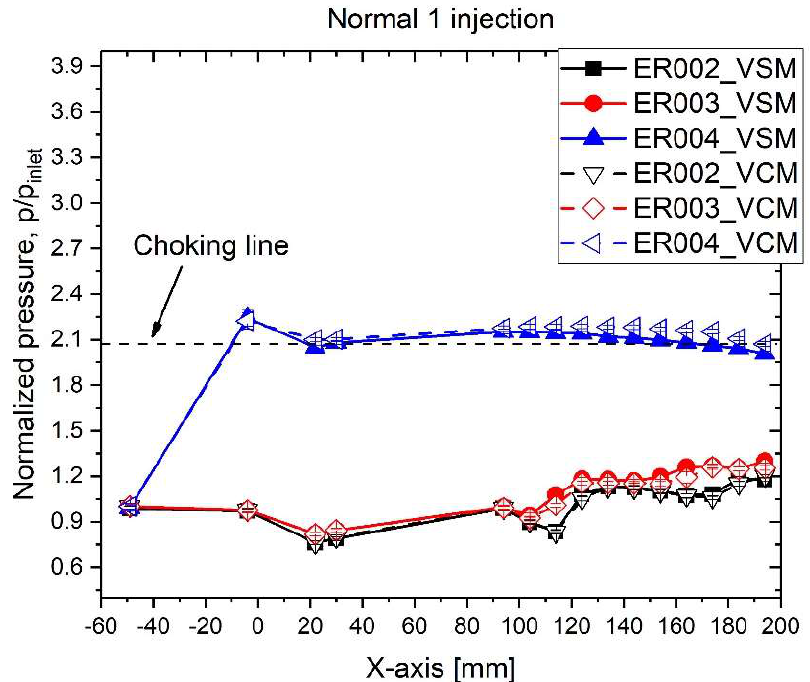
Figure 9. Combustion pressure distribution of the normal 1 injection for ER rise: VCM—vent circle mixer, VSM—vent slot mixer, ER—equivalence ratio.